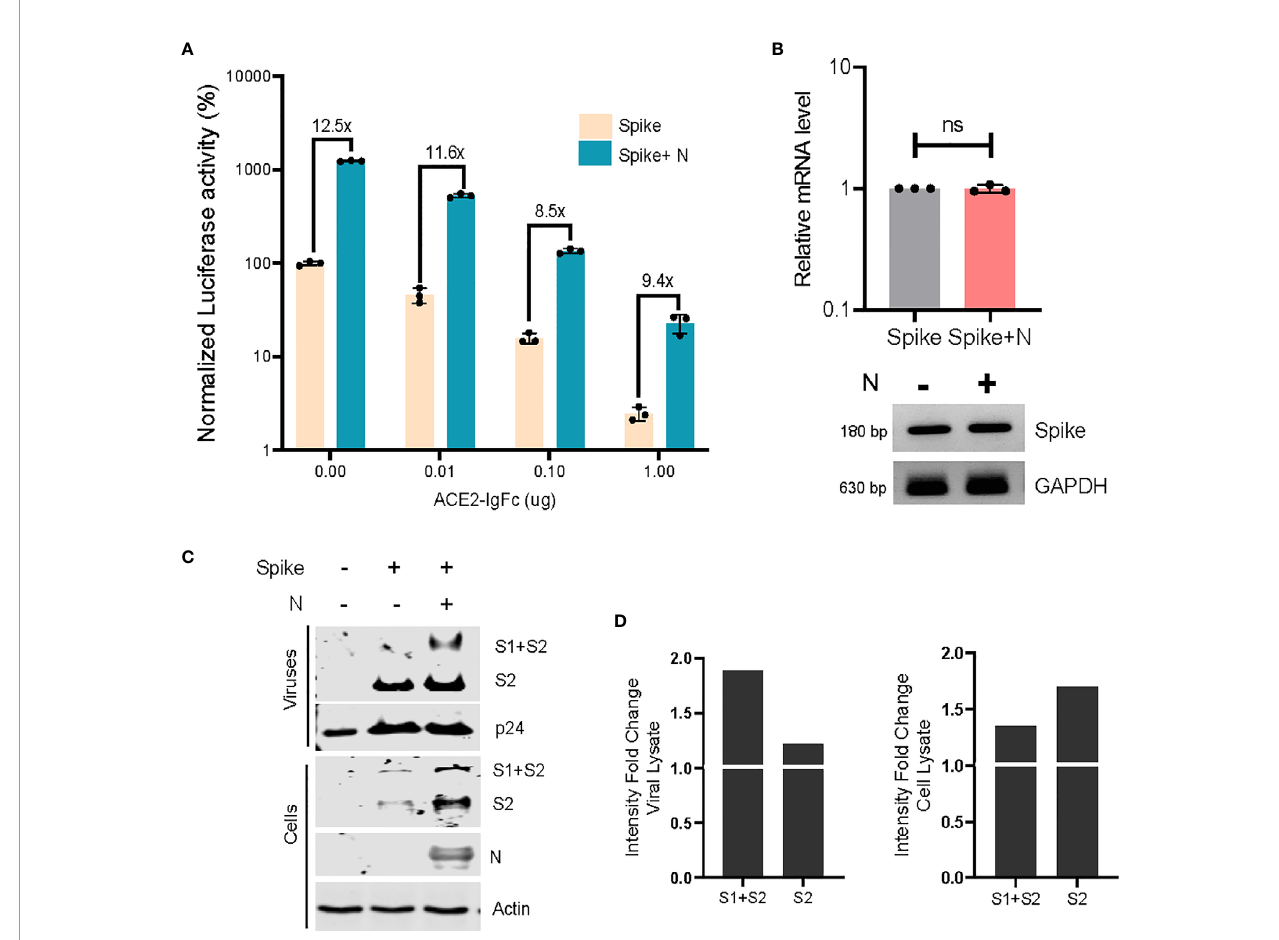
FIGURE 4 | Neutralizing effects of ACE2-IgFC on the N-enhanced spike lentiviral particles and biochemical characterization of the virions (A) Neutralization assay using ACE2-IgFc pre-treated lentiviral particles with indicated amount of ACE2-IgFC (on the x-axis) for the lentiviral particles produced in the presence of indicated genes. The particles were normalized to the reverse transcriptase units obtained from the SGPERT assay. Luciferase activity obtained from non-enveloped particle transduction was considered as baseline, and the data represented has been normalized to the spike-only condition without the addition of ACE2-IgFc. The lines represent extent of residual infectivity (expressed as x-fold), post-treatment of ACE2-IgFc, with respect to N-exclusive particles n=3 ± SD. (B) RT-PCR analysis of the mRNA fraction from cells transfected with either spike or spike + N protein. Both quantitative RT-PCR and representative semi-quantitative PCR results are shown. n=3 ± SD. (C) Biochemical analysis of the virus particles and the corresponding cell lysates. The viral proteins were visualized by western blotting using antibodies raised against S2 domain of SARS CoV2 spike. (D) Densitometric analysis of the band intensities were obtained by normalizing the S1+S2 and S2 bands to either the respective p24 levels for viral lysate or the Actin levels for cell lysate and calculating the fold change of the normalized intensities of bands in the N-inclusive condition to the spike-only condition. The N protein and p24 were detected using Anti-Strep tag and anti-p24 antibody respectively. Actin served as loading control. n=3, representative blots are shown. NS, Non signi fi